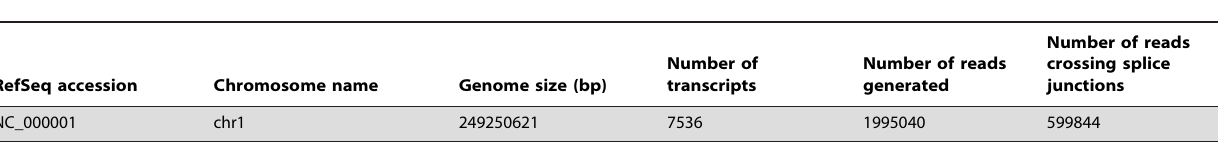
Table showing the summary of reads simulated using the RiSER J s framework and the first human chromosome (chr1) as the reference. doi:10.1371/journal.pone.0076935.t006 PLOS ONE |